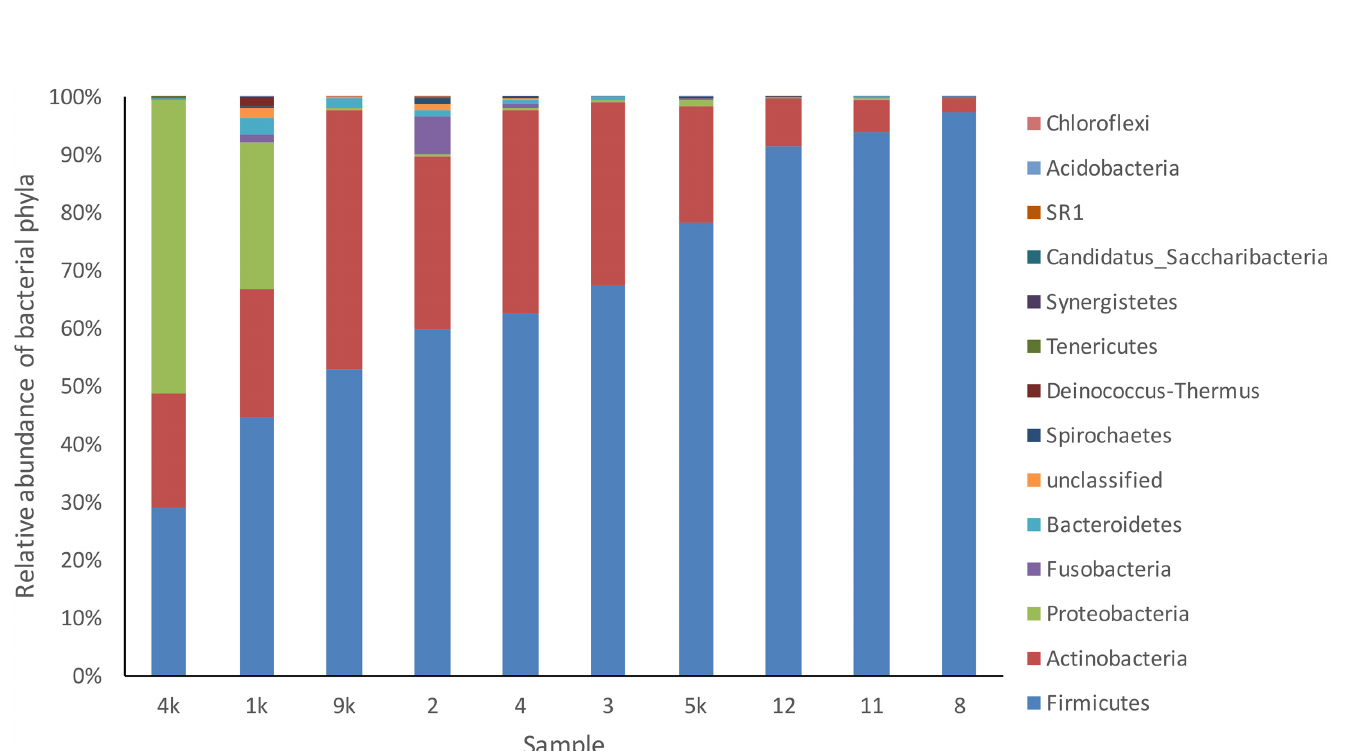
Fig 2. Taxonomic assignment (phylum level) of the 706 OTUs found in deep caries samples.